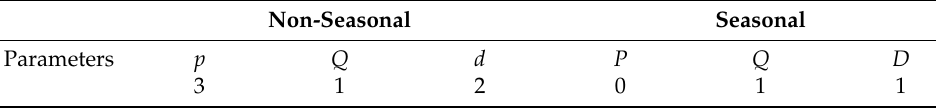
Table 4. Parameter ranges used for the SARIMA model.